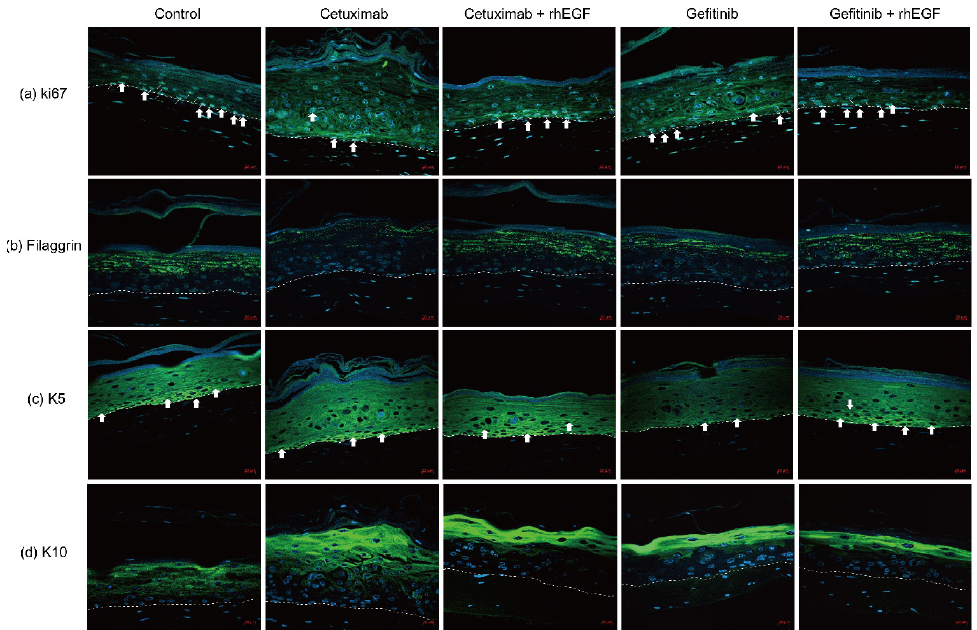
Figure 2. rhEGF normalized proliferation and differentiation of epidermis-erupted EGFRIs. Expression of ki67 in the nucleus of keratinocytes in the epidermal basal, para-basal cell layer (white arrow) ( a ). Expression of filaggrin in upper epidermis ( b ). K5 expression was seen in the epidermal basal layer (white arrow) ( c ). K10 expression was observed in upper epidermis, especially in the stratum corneum ( d ). (Magification, ×20, Scale bar: 20 μ M)